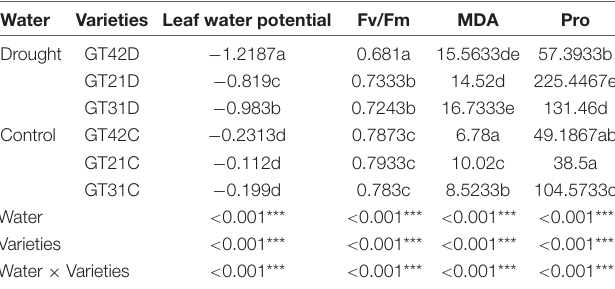
TABLE 1 | Soil physical and chemical properties were significantly different under different